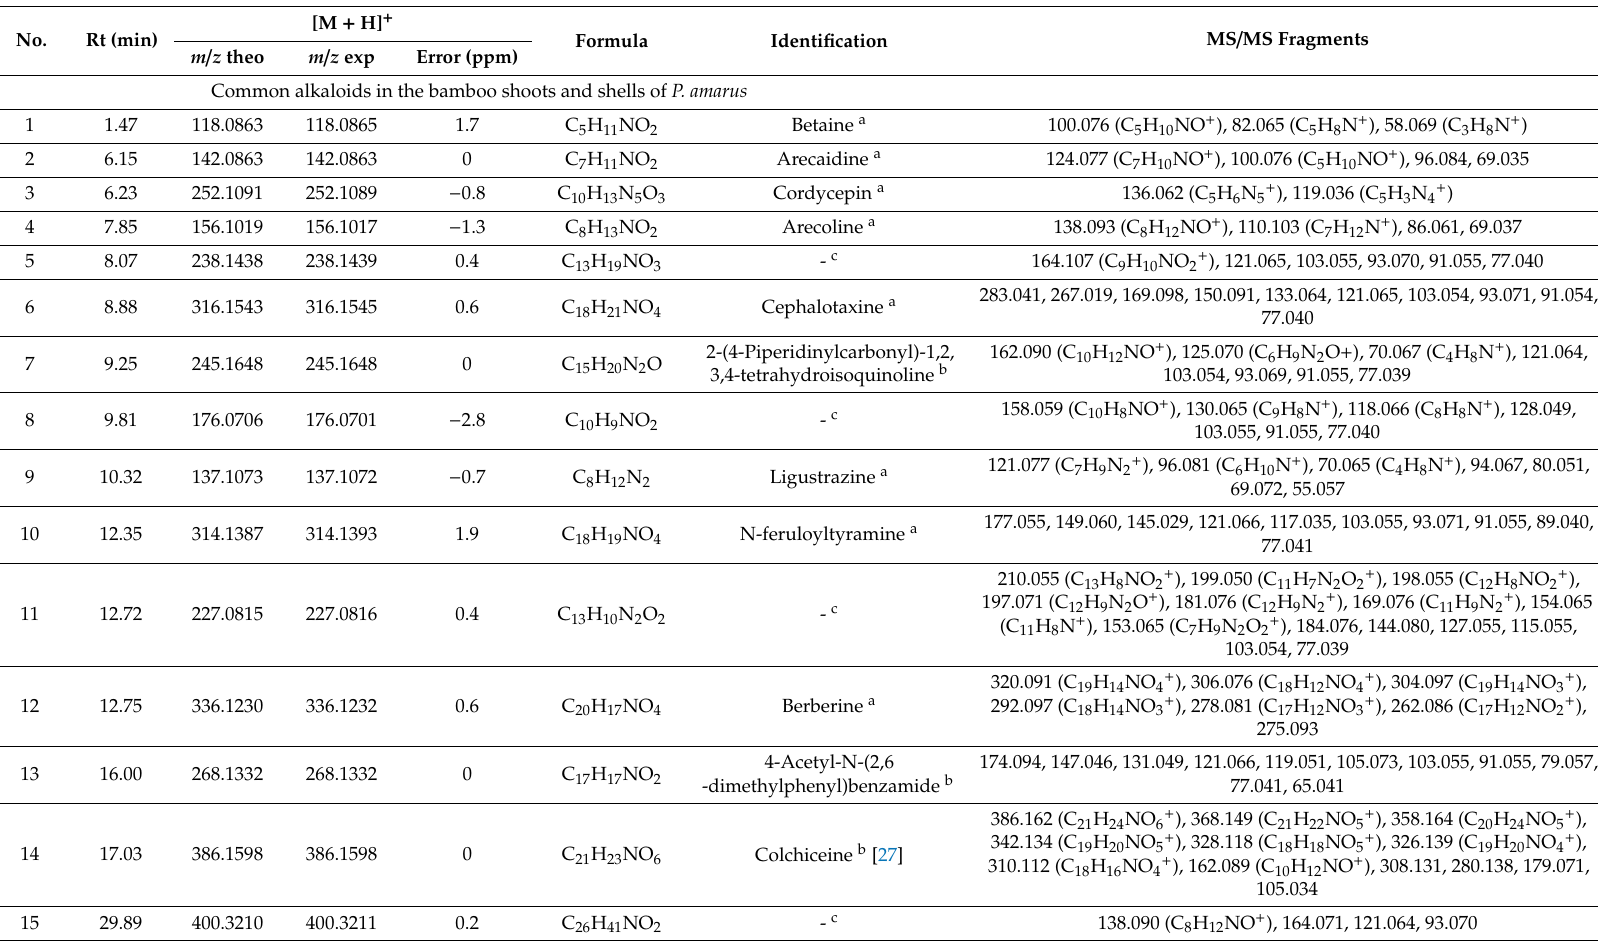
Table 1. Identification of alkaloids in the bamboo shoots and shells of P. amarus by UHPLC / QTOF-MS / MS in positive